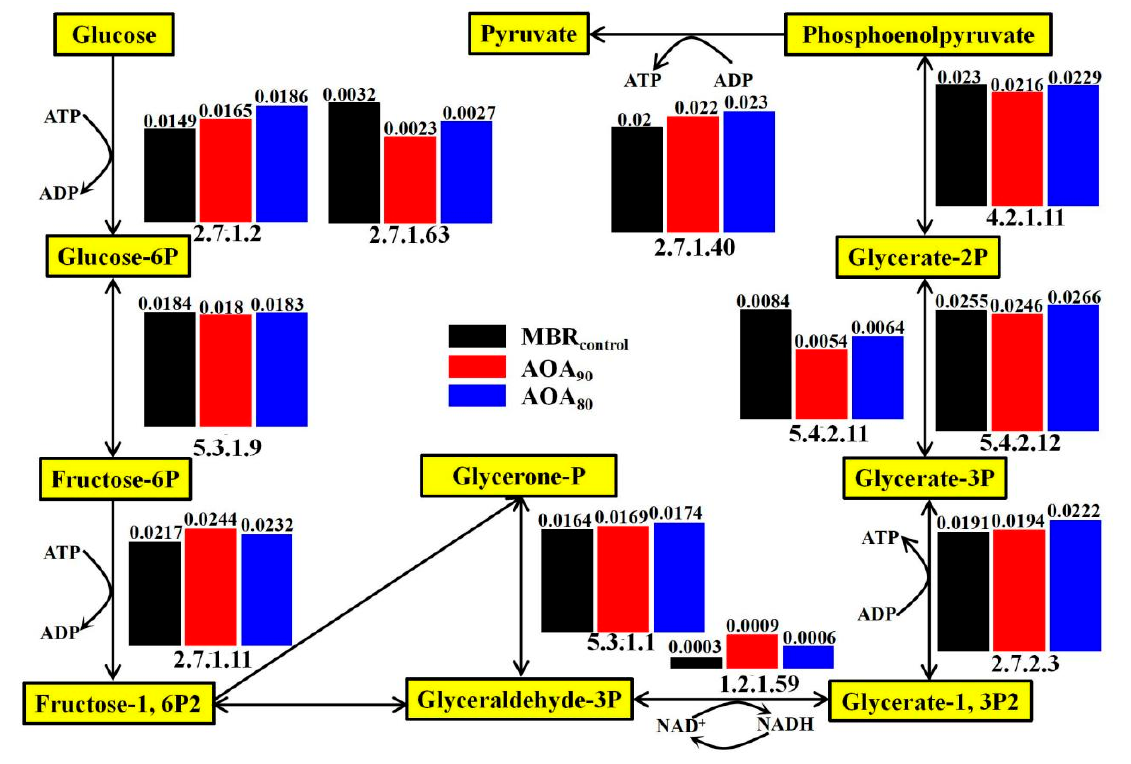
Figure 6. Diagram of glycolysis pathway and the average relative abundance of genes encoding enzymes (identified by their EC number) in MBR control , AOA 90 and AOA 80 .